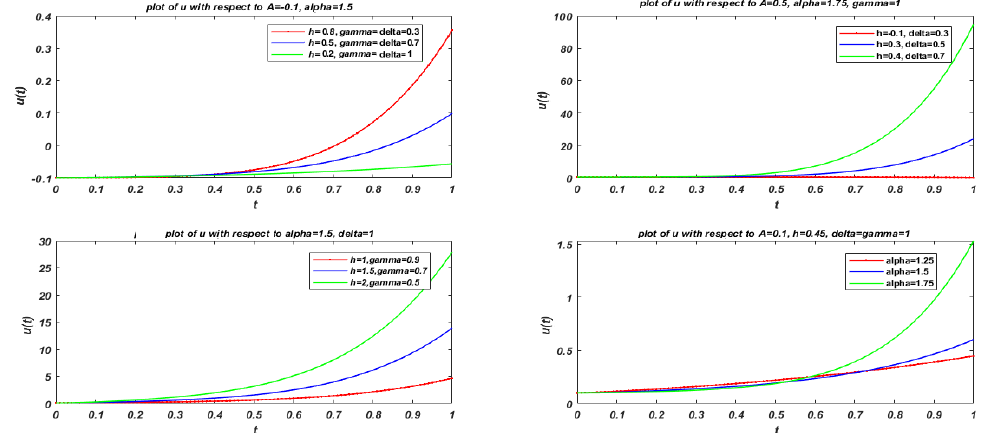
Figure 2. Plots of the Optimal Homotopy Asymptotic Method’s (OHAM’s) solutions u ( t ) according to different values of A , δ , γ and α .